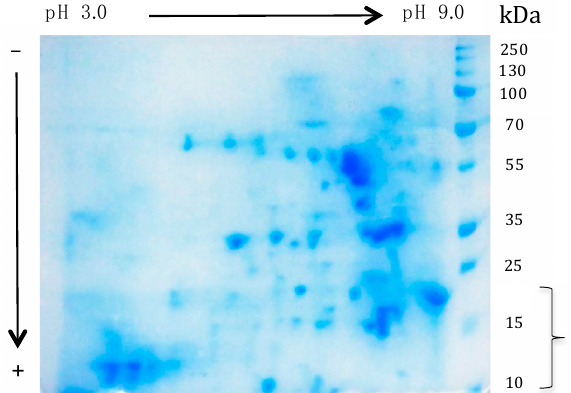
Figure 7. Bidimensional SDS-PAGE electrophoregram of the mealworm protein extract stained with Coomassie blue. A number of protein fractions with a MW in the range between 10 kDa and 100 kDa, occur between pH 3.0 and pH 9.0. Low MW protein fractions containing the apoLp-III, LCP and the 12 kDa-HLP allergens occur at the bottom of the gel (*).